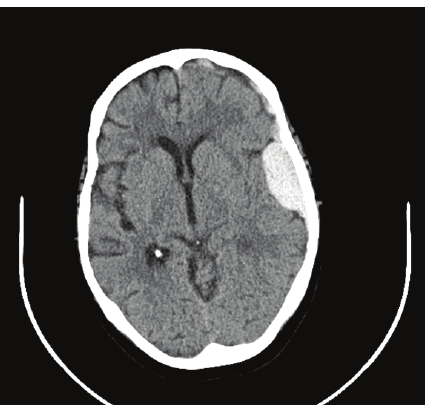
Figure 1: Initial axial CT head without contrast.